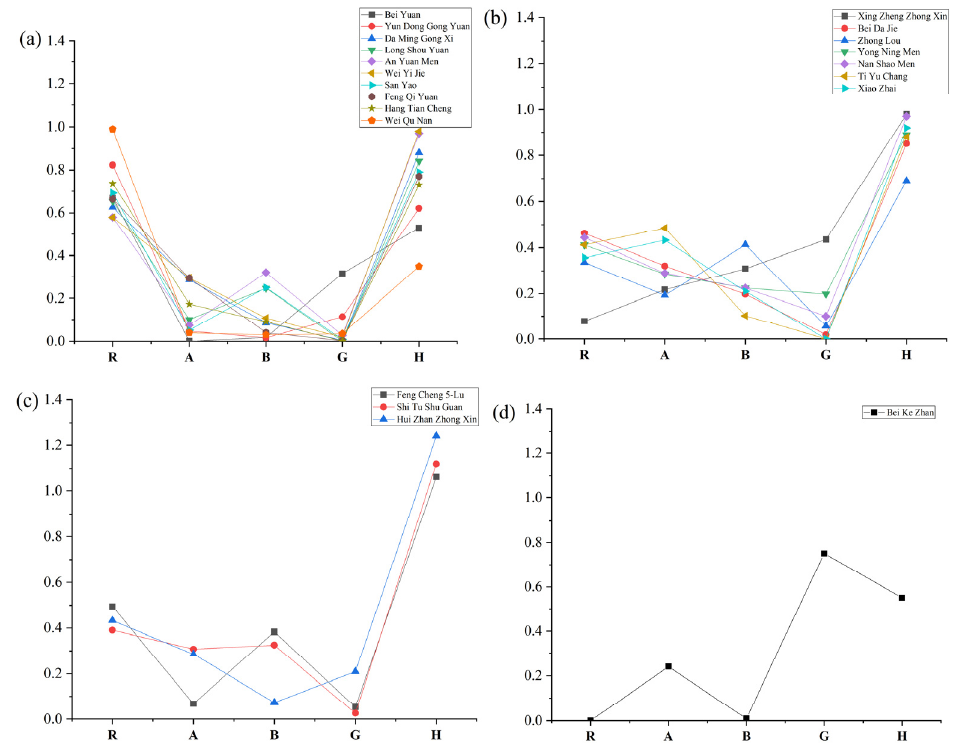
Figure 6. ( a ) Residential; ( b ) business; ( c ) mixed; and ( d ) traffic